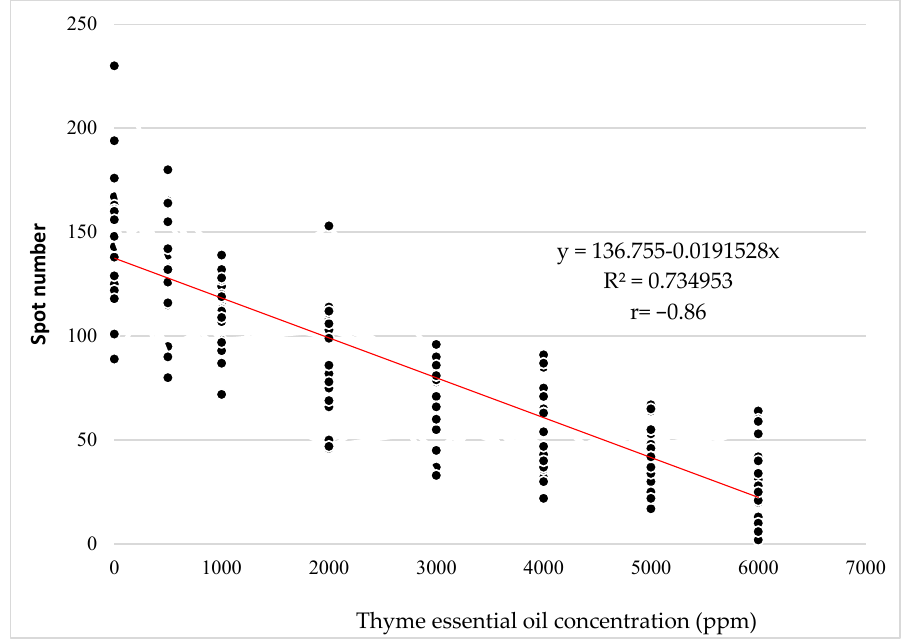
Figure 1. Effect of the thyme EO concentration on the number of local lesions on the Ch. quinoa plants inoculated with the CMV ‐ S21 isolate.